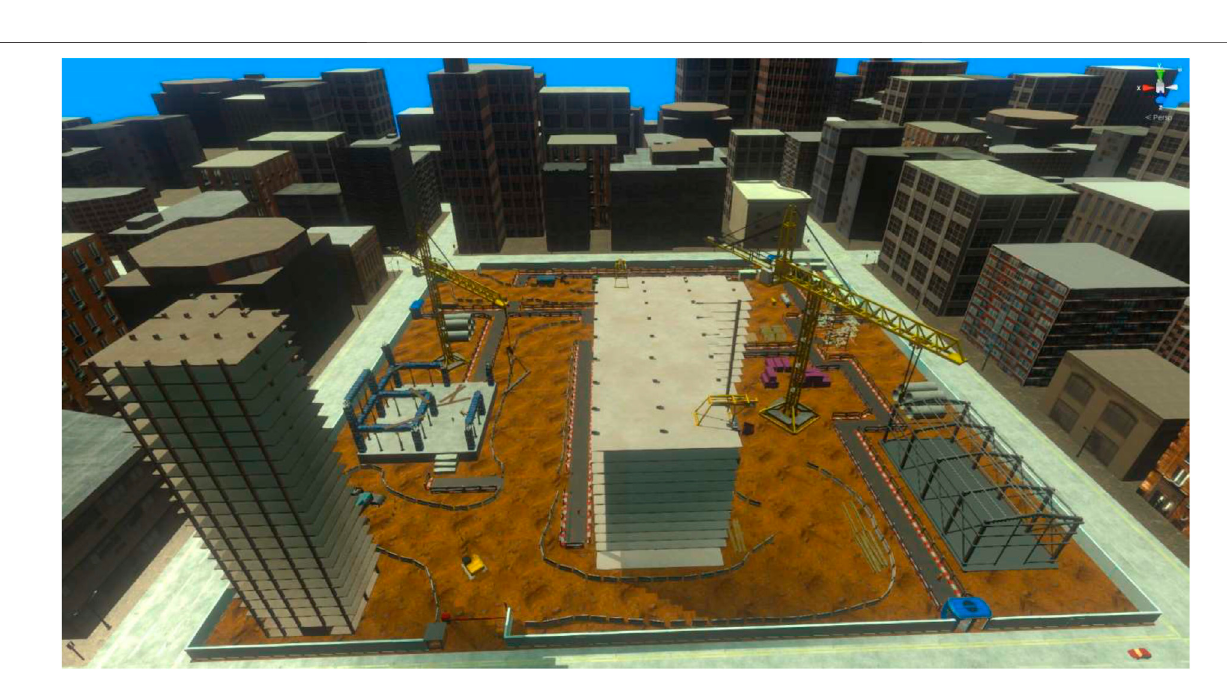
Frontiers in Built Environment |